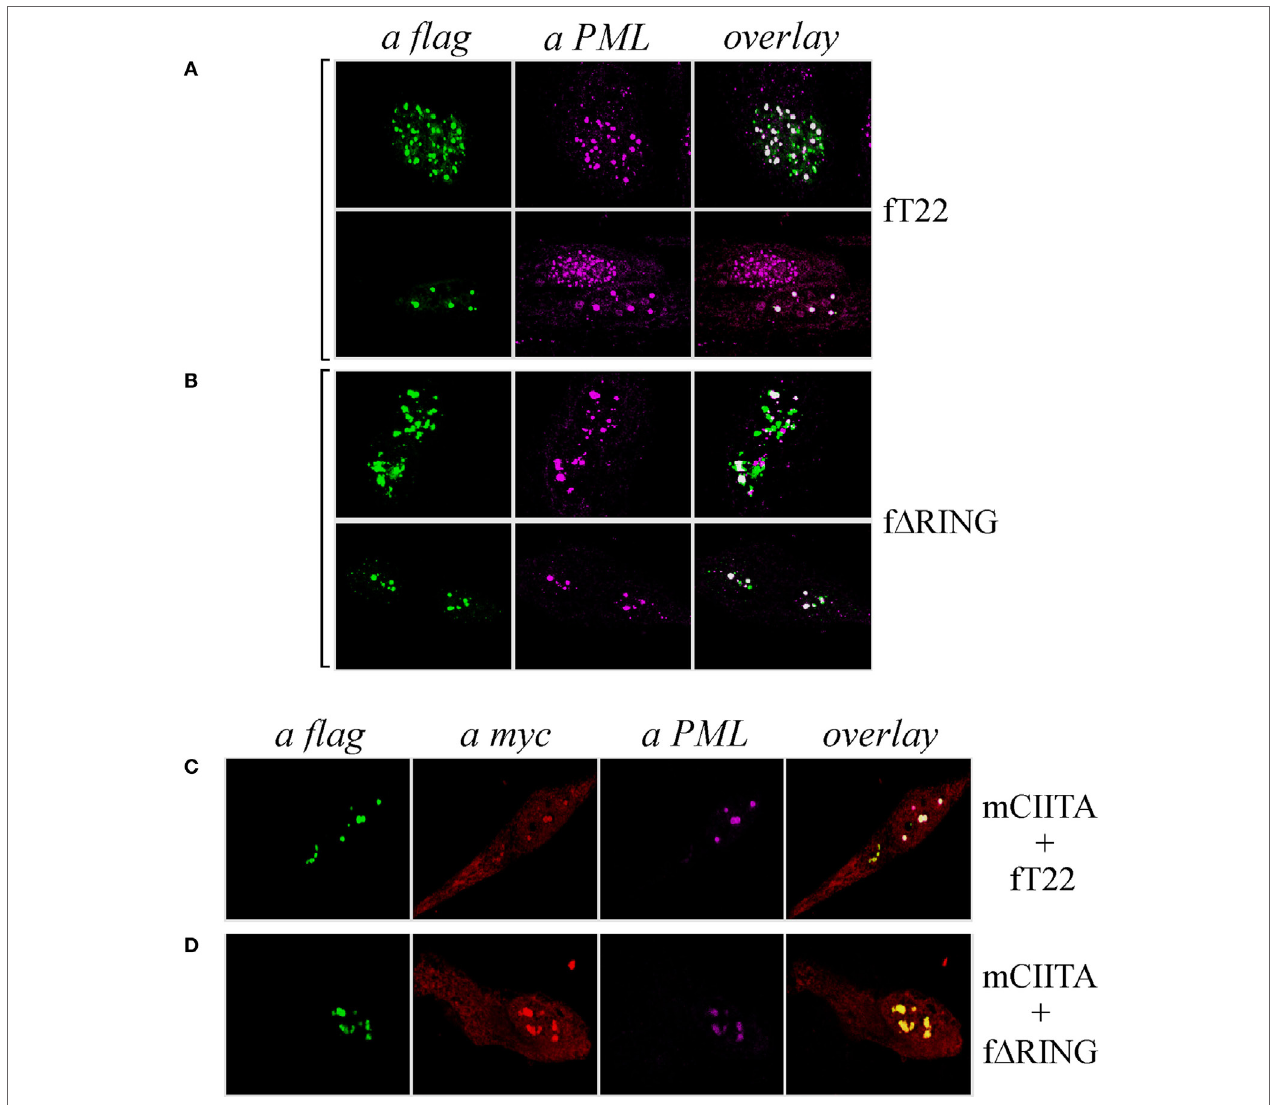
FigUre 4 | class ii transactivator (ciiTa) colocalizes with tripartite motif-containing protein 22 (TriM22) and promyelocytic leukemia (PMl) in nuclear bodies . Hep-2 cells were transfected with flag-tagged TRIM22 (fT22) (a) or with flag-tagged TRIM22- Δ RING (f Δ RING) (B) expression vectors, incubated with the antibodies listed on the top and analyzed by immunofluorescence and confocal microscopy. Each panel shows two representative fields. Endogenous PML was detected by using the anti-PML mouse monoclonal antibody followed by goat anti-mouse AlexaFluor 546-conjugated antibody. Flag-TRIM22 and flag- Δ RING were detected by direct staining with fluorescein isothiocyanate-conjugated anti-flag antibody. Confocal microscopy analysis was carried out in Hep-2 cells transfected with fTRIM22 (c) or with f Δ RING (D) expression vectors in the presence of myc-tagged CIITA plasmid, as indicated on the right of the panels. CIITA protein was detected by using the anti-myc rabbit polyclonal antibody followed by goat anti-rabbit AlexaFluor 647-conjugated antibody. Endogenous PML protein was detected by using the anti-PML mouse monoclonal antibody followed by goat anti-mouse AlexaFluor 546-conjugated antibody. TRIM22 and TRIM22- Δ RING were detected as in (a, B)